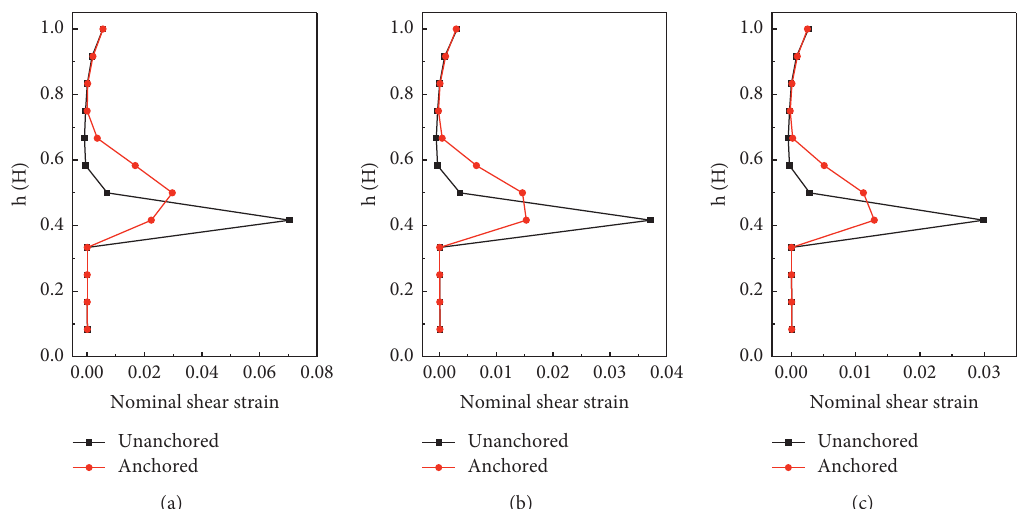
Figure 10: Nominal shear strain distribution along the elevation of the slope surface at different frequencies: (a) frequency is 1 Hz; (b) frequency is 2 Hz; (c) frequency is 4Hz.